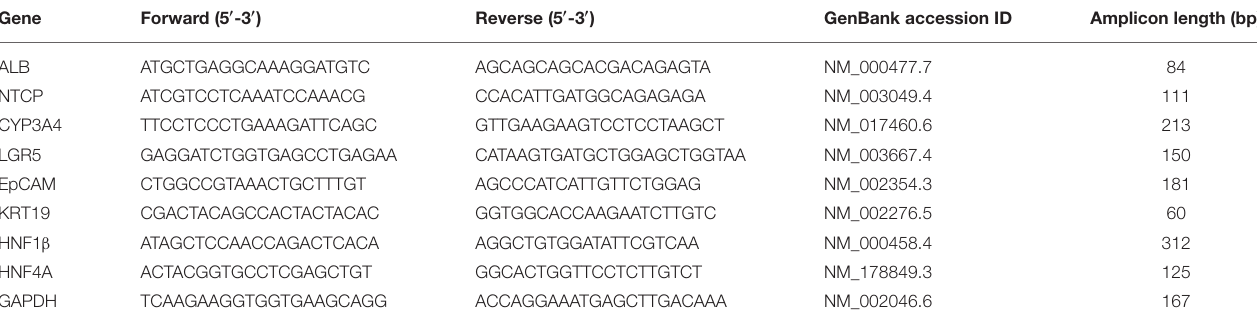
TABLE 1 | Primer sequences for real-time PCR